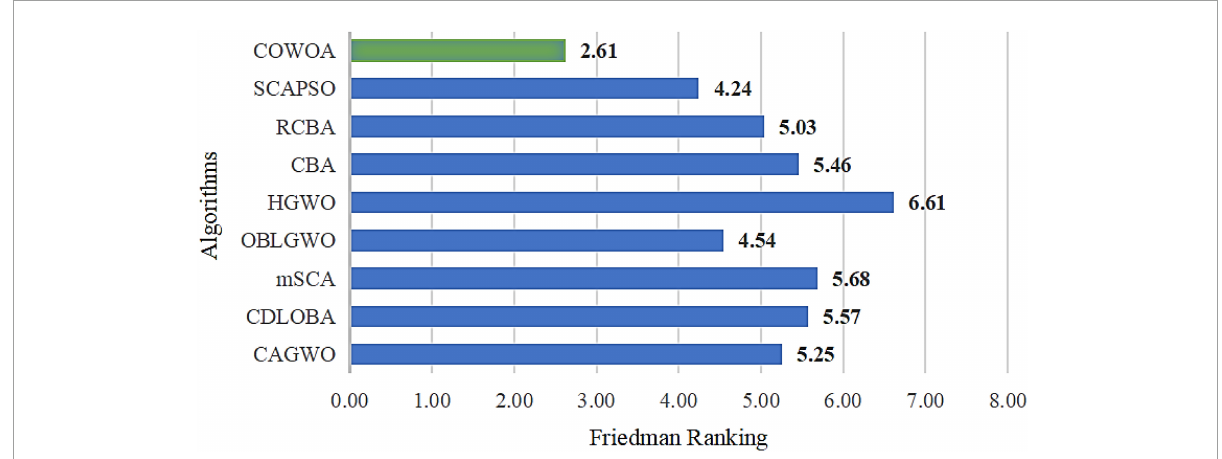
FIGURE12 Result of Friedman ranking between the COWOA and the well-known variant algorithms.